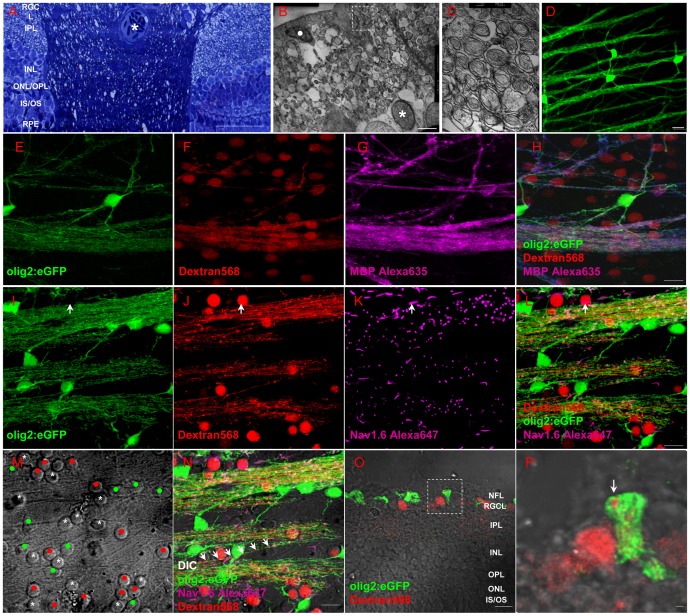
Oligodendrocytes exist within retina of adult zebrafish.(A) Toluidin blue staining shows myelin structure through the lamina cribrosa into the retina. (B-C) TEM images show that the axons of RGCs are specially and loosely wrapped by myelin. (D) Olig2:eGFP cells in retina have perfect structure of oligodendrocyte cells that project several processes to vicinal axons in Tg(olig2:eGFP) transgenic line. (E-H) Combination of Dextran568 labeled RGCs and MBP staining show olig2+ eGFP expression on mature oligodendrocytes in NFL. Notice that only the myelin ensheathed axons are MBP positive. (I-N) With Ranvier node on myelin, oligodendrocytes in zebrafish retina are in mature state. Arrow in (I-L) points out an axon hillock near RGC soma, and it should be noticed that olig2+ process dose not wrap this area. Red dots in (M) indicate RGCs, green dots are olig2+ cells and * indicates non-labeled cells, a row of arrows in (N) show an axon is wrapped by olig2+ process. (O) Crossing section indicates that axon retrogradely labeled by Dextran568 is wrapped by olig2+ eGFP. (P) Details of the white square in (O). Scale bar: 50 µm (A); 2 µm (B); 200 nm (C); 10 µm (D-O); 1 µm (P).